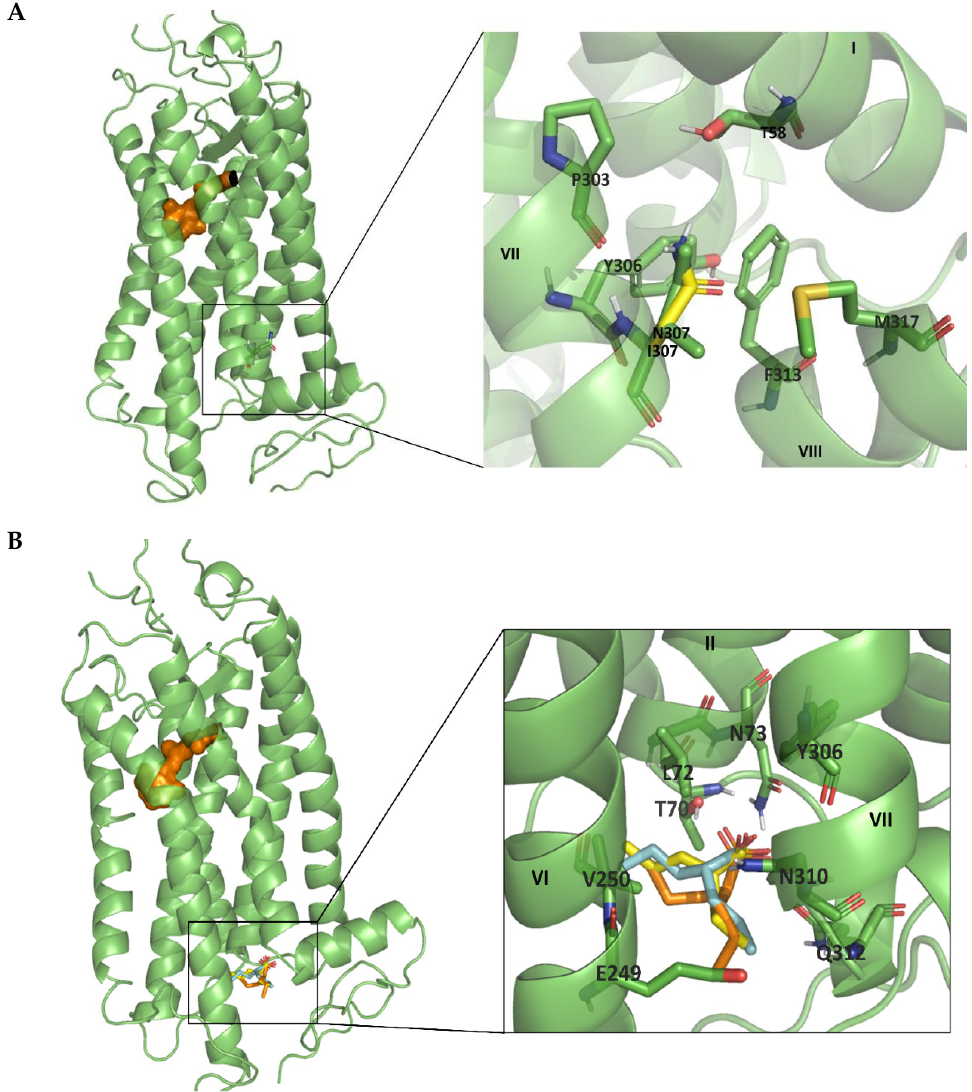
Figure 7. ( A ) . Structure of Rho receptor, PDB code 1U19, focusing on the position of Ile307. Detailed representation of the Ile307 position and the nearby residues can be observed on the right, where the mutation to Asn is represented in bright yellow. ( B ). Potential VPA binding site to the intracellular domain of Rho. Positions of the best three poses of VPA docking, with values of the scoring function of − 4.5, − 4.4, and − 4.4 kcal/mol, respectively, are represented in cyan, bright yellow, and orange.